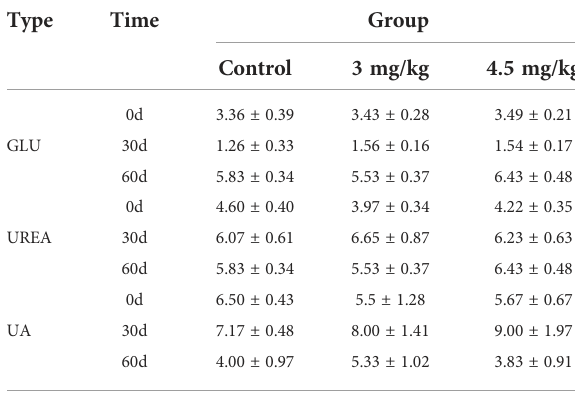
TABLE 4 Effects of implanted melatonin on sheep kidney